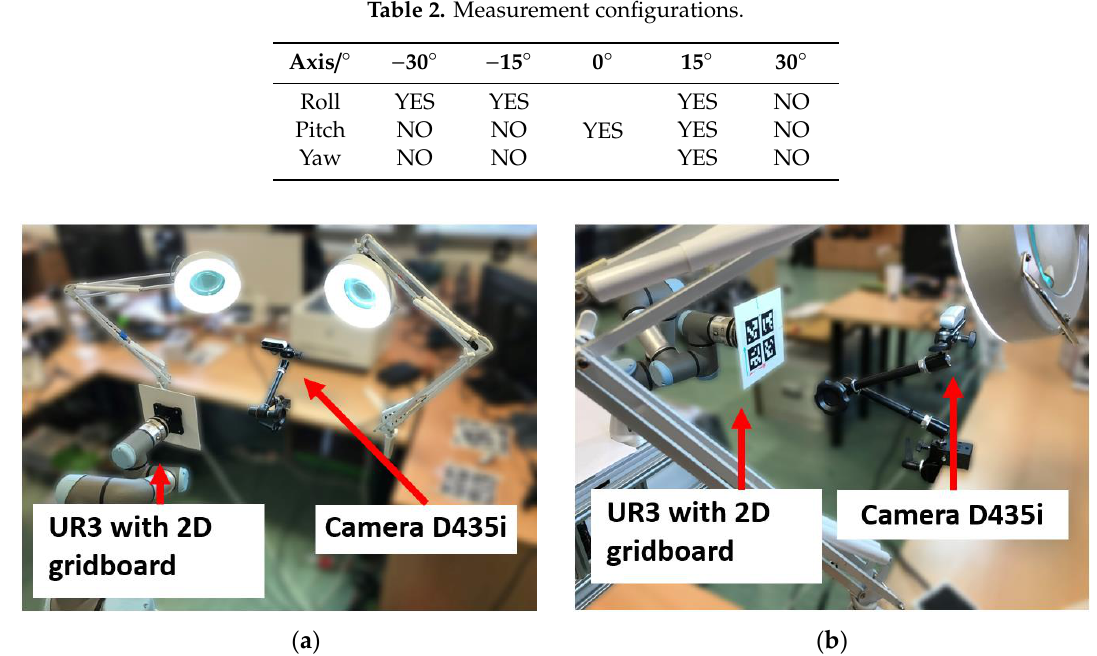
Figure 4. Measuring workplace ( a ) back view; ( b ) front view.